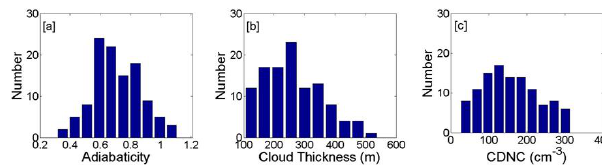
Fig. 3. Distribution of the (a) adiabaticity, (b) geometric vertical thickness and (c) cloud droplet number concentration among 116 clouds profiled by the G-1 and C-130 during VOCALS.